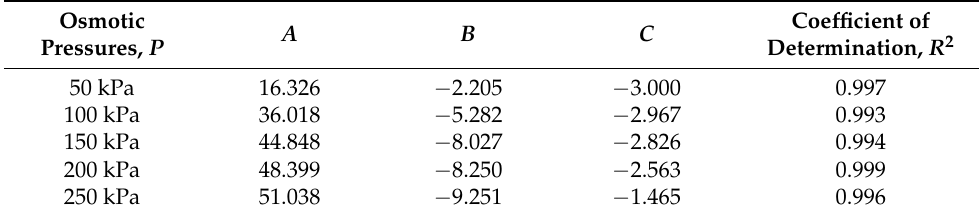
Table 8. Values of A , B , C for hydraulic conductivity coefficient expression.